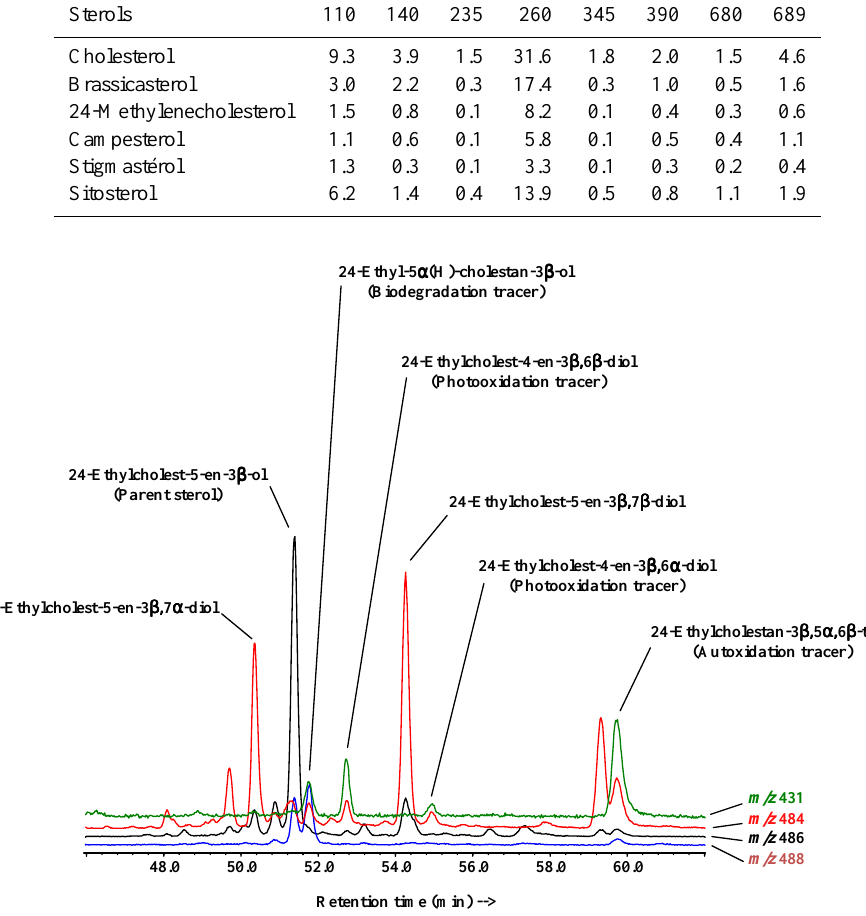
Fig. 3. Partial m/z 486, 488, 484 and 431 ion chromatograms showing presence of sitosterol degradation products in the total lipid extract of surface sediments (0–1cm) collected at the station